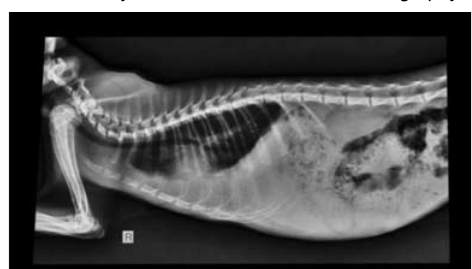
Fig. 3: Thoracocentesis at 7 th left intercostal space revealed yellowish white pus like pleural fluid